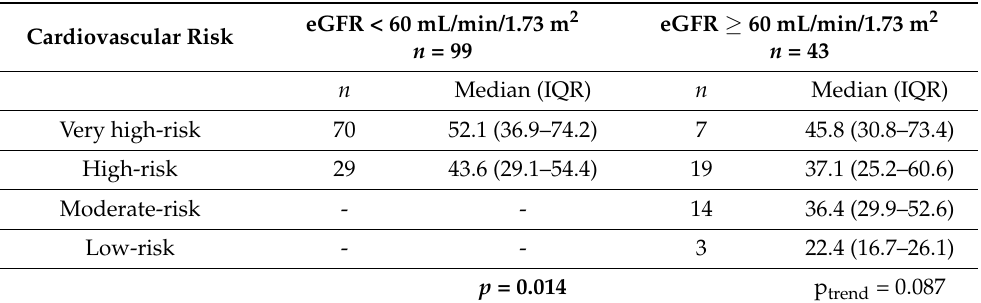
Table 2. Resistin concentrations in CKD patients and the control group according to the estimated cardiovascular risk. eGFR < 60 mL/min/1.73 m 2 Cardiovascular Risk